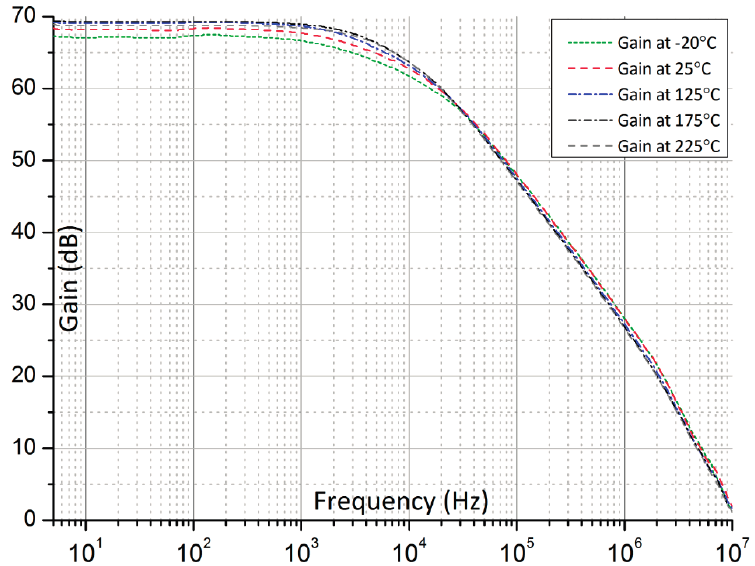
Figure 4. Measured open-loop frequency response of the folded-cascode amplifier at different